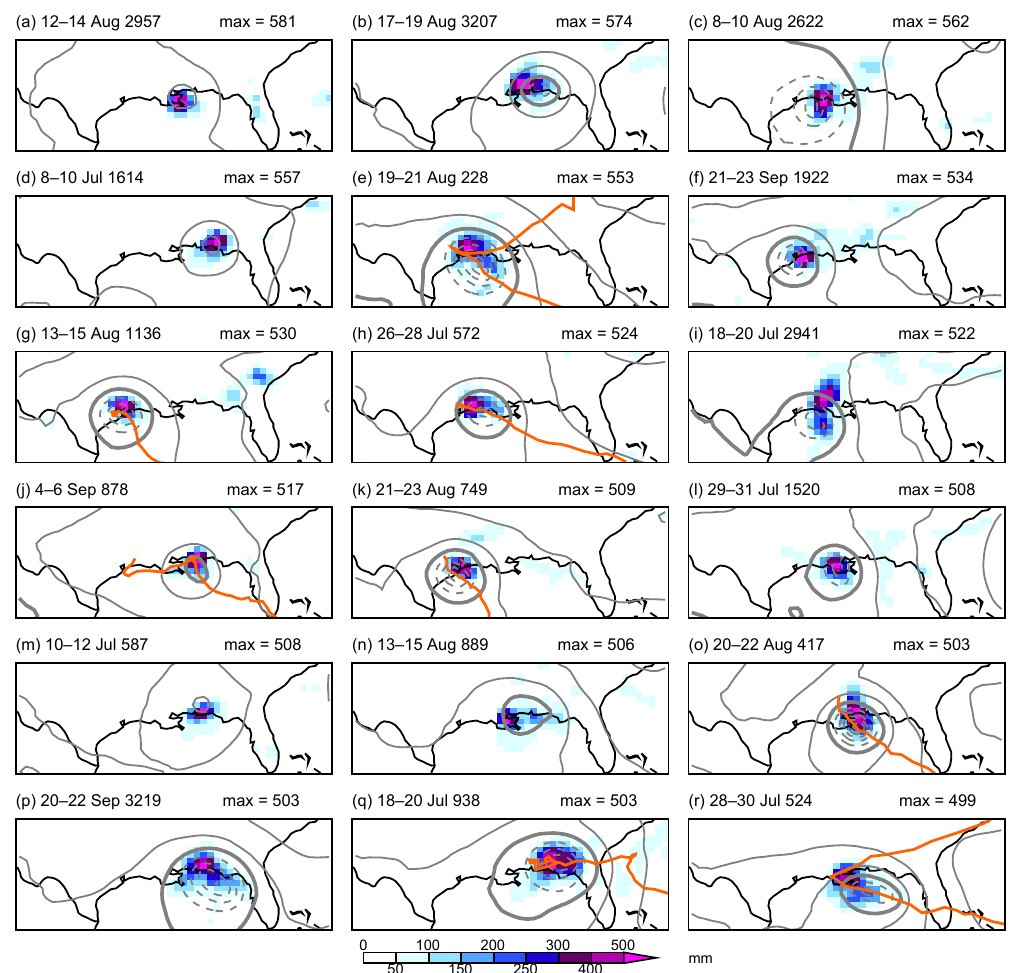
Figure 9. The same as Fig. 8 but for the top 18 maximum extreme precipitation events in the 1860 FLOR-FA static forcing experiment. Note that years are model years and do not resemble dates on the real-world calendar and that the model provides precipitation information over ocean grid boxes